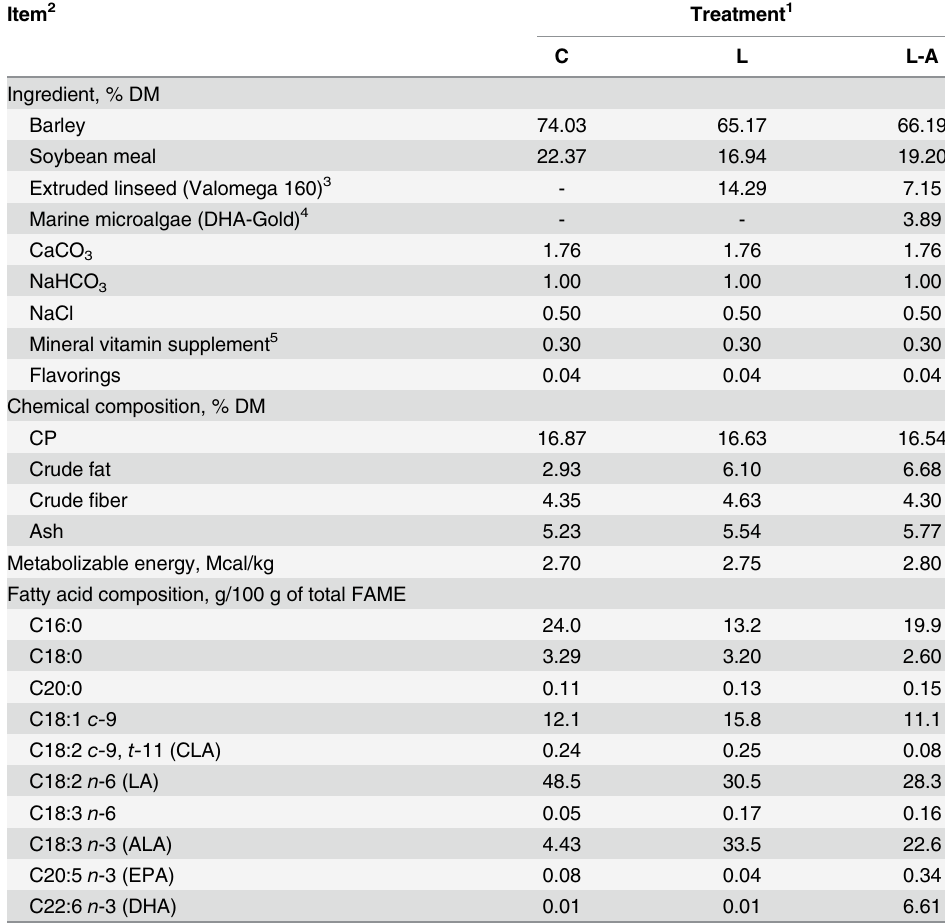
Table 1. Ingredients, chemical composition and fatty acid composition of experimental diets. Item 2